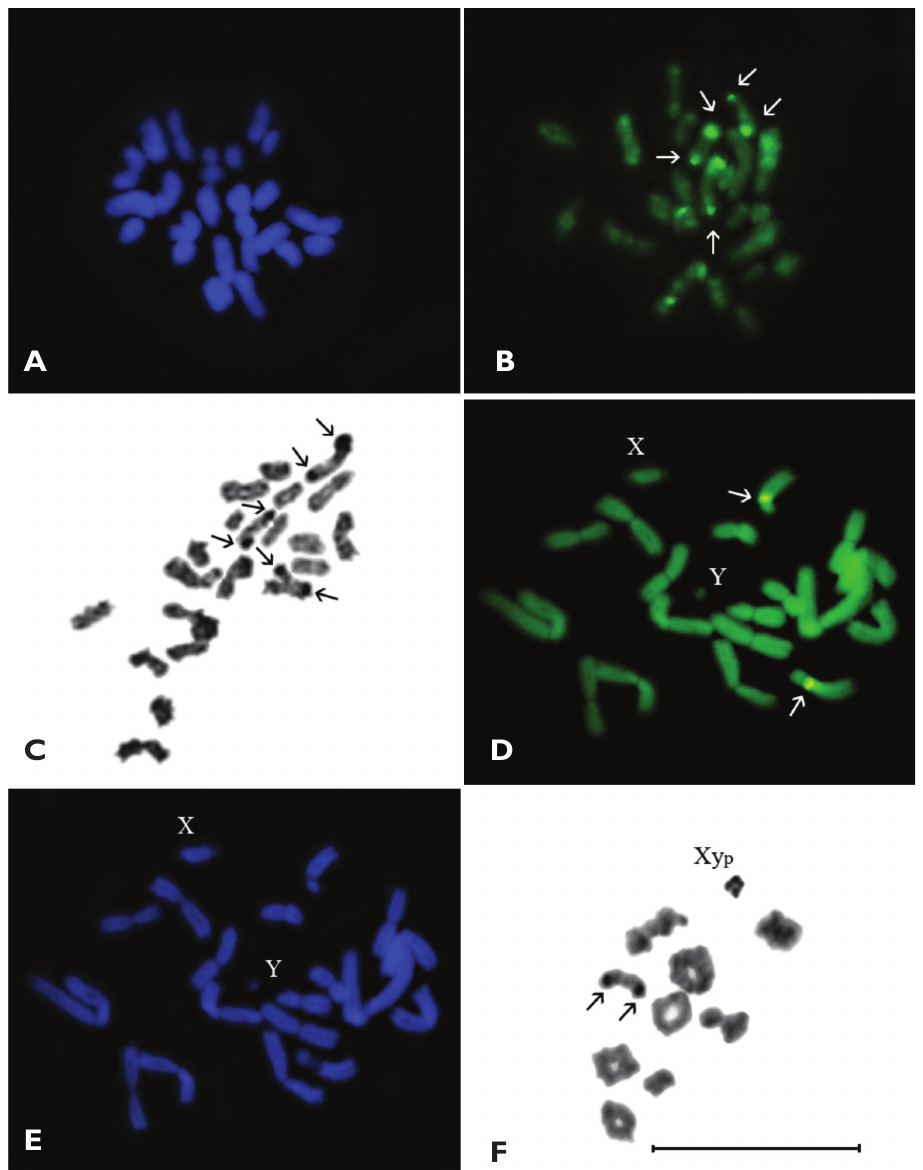
Figure 2A–F. A–C Sphenoptera scovitzii , n=19-23, metaphase I. A DAPI staining; B CMA ing; C Ag-banding D–F Dicerca aenea validiuscula , n=9AA+Xy e mitotic metaphase (DAPI staining) F diakinesis/prometaphase I (Ag-banding). Bar = 10 µm. and 5 pairs of middle-sized metacentrics, 2 pairs of middle-sized submetacentrics and 1 pair of middle-sized subtelocentric. The X-chromosome was middle-sized and acro- centric, Y-chromosome was dot-like with unclear morphology. In mitotic